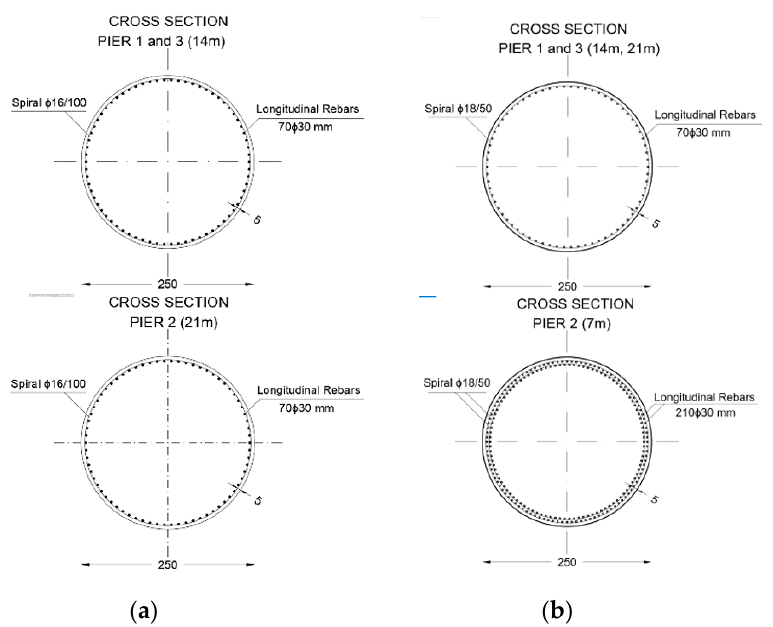
Figure 7. ( a ) Regular bridge: pier sections. ( b ) Irregular bridge: pier sections.